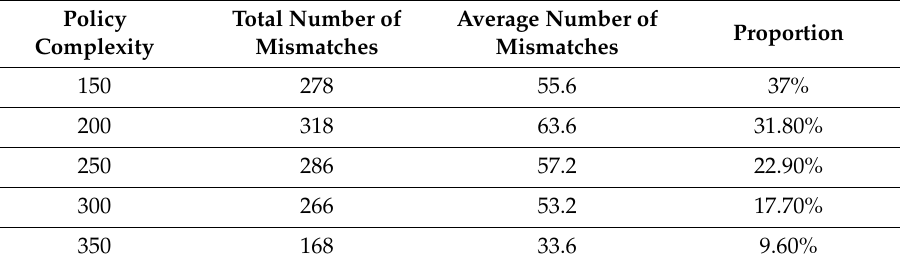
Table 4. Proportion of avp mismatch under di ff erent policy complexity.